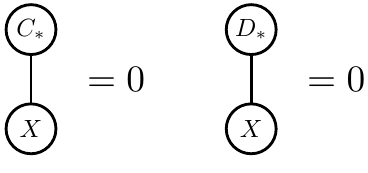
Figure 18: The decorated constraints forcing the structure of the tiles X × C ∗ and X × D ∗ for X ∈ B ∗ \ B G